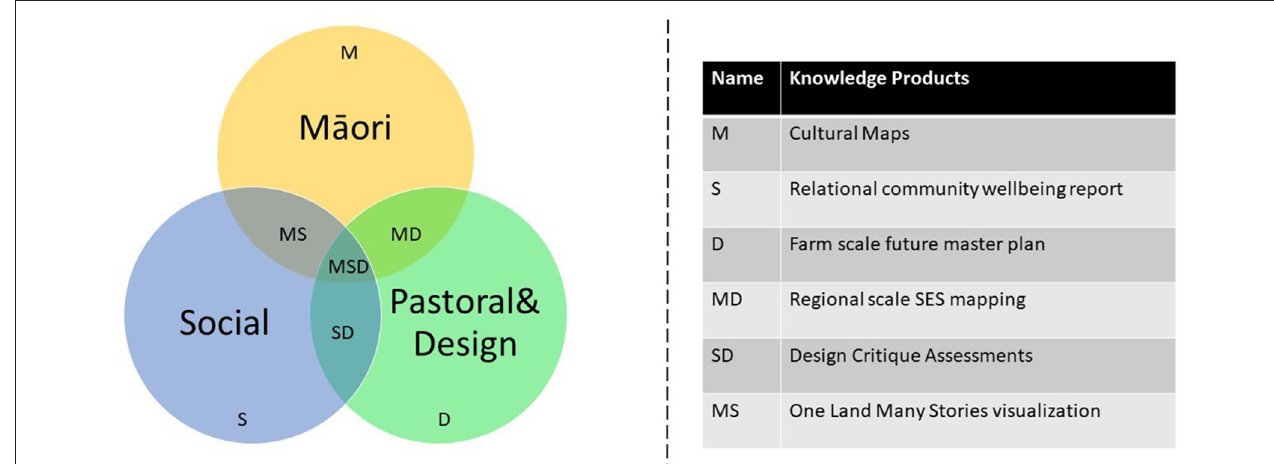
FIGURE 9 | Knowledge co-production at the COE across different teams.